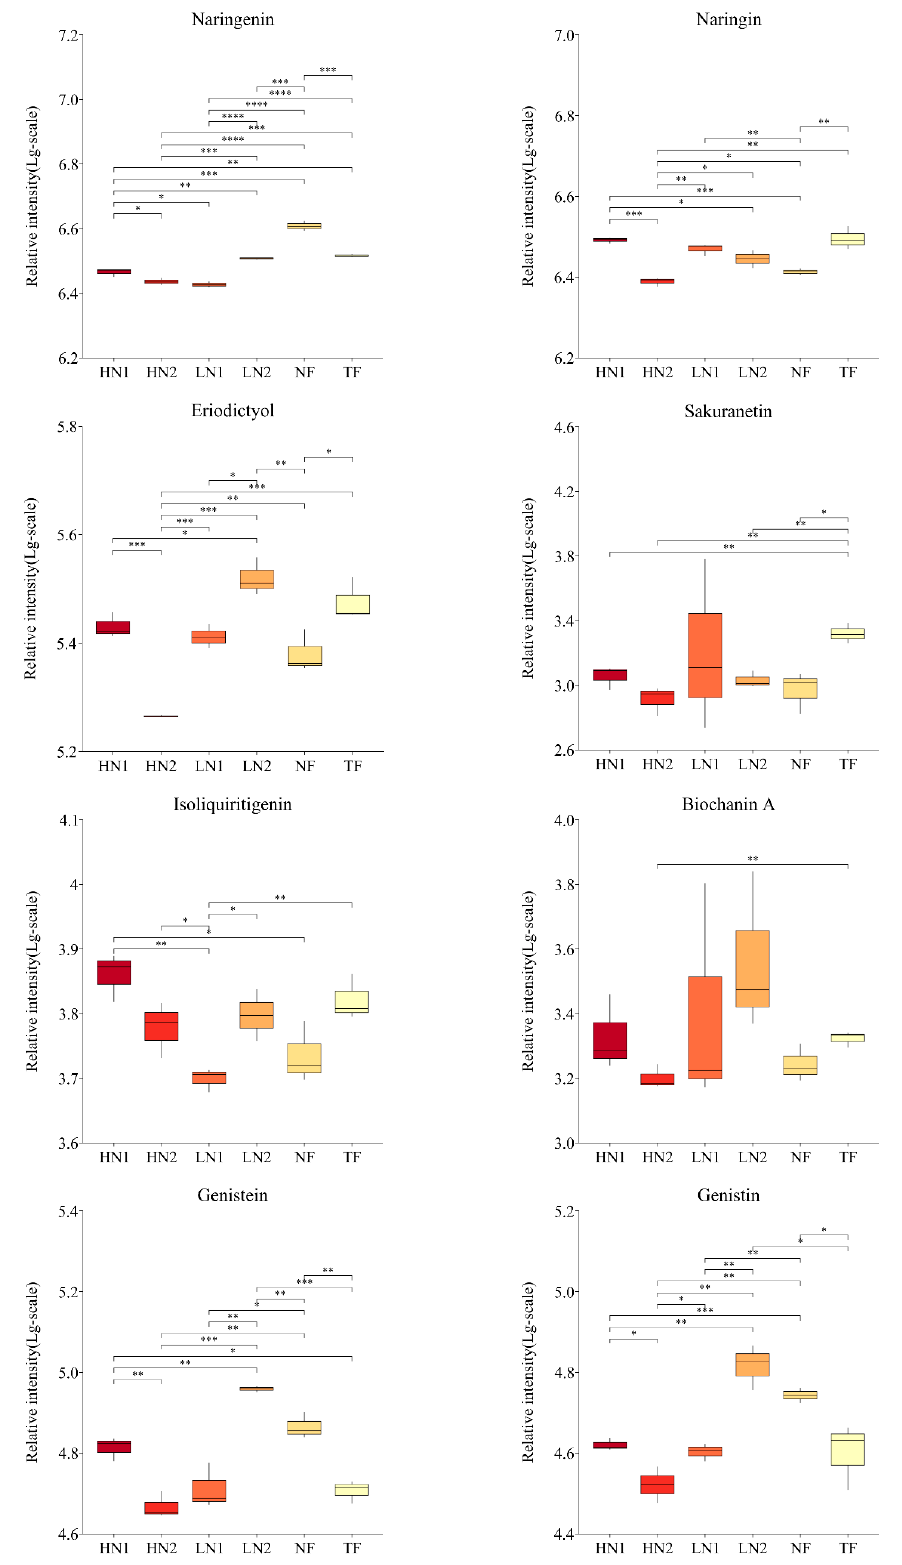
Figure 4. Changes in flavonoid compound accumulation in tea leaves with different N supplies. This figure shows the 26 kinds of flavonoid compounds detected. The statistical approach used was a two-tailed t -test. Every group contains 3 tea leaf samples. ****, ***, **, * indicates a significant difference at p < 0.0001, p < 0.001, p < 0.01, and p < 0.05,